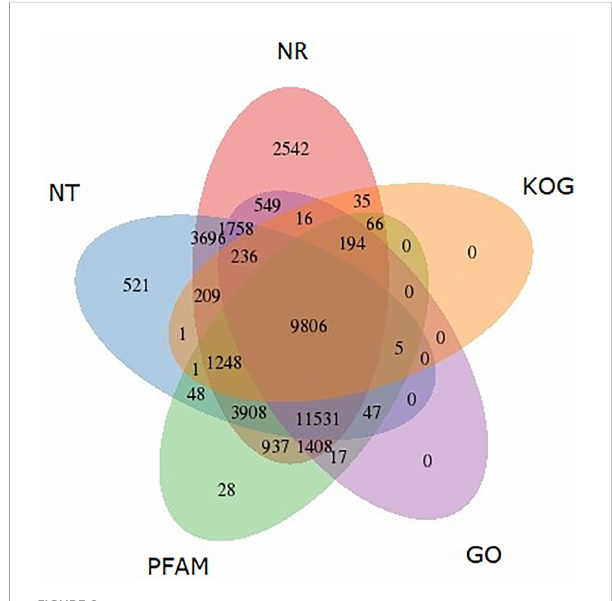
FIGURE 2 Venn diagram shows the BLAST results of M. indica against fi ve databases, including NT, NR, KOG, GO and PFAM. The number of transcripts with signi fi cant hits is presented in each intersection of the Venn